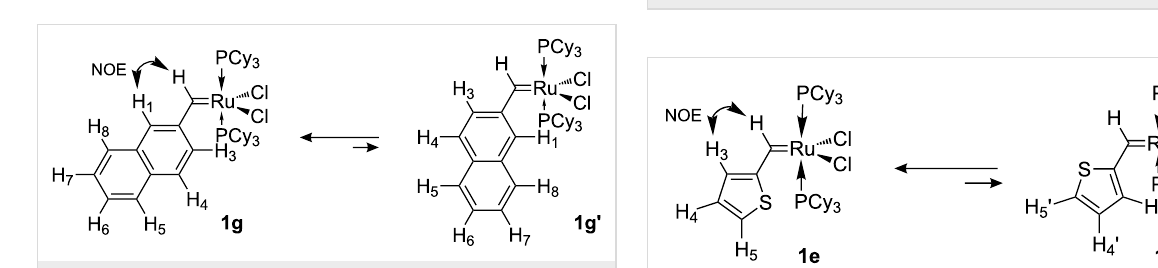
Figure 2: 1 H NMR (top) and NOE difference spectrum (bottom) of 1g in CD 2 Cl 2 at − 80 °C, saturating the methylidene H signal at δ = 19.75 ppm.